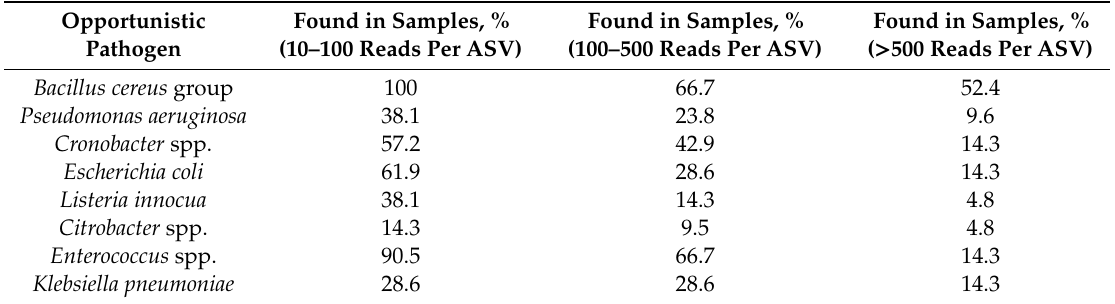
Table 2. The prevalence of opportunistic bacteria at di ff erent threshold values for the number of reads per ASV. Opportunistic Found in Samples, % Found in Samples, % Found in Samples, % Pathogen (10–100 Reads Per ASV) (100–500 Reads Per ASV) ( > 500 Reads Per ASV) Bacillus cereus group